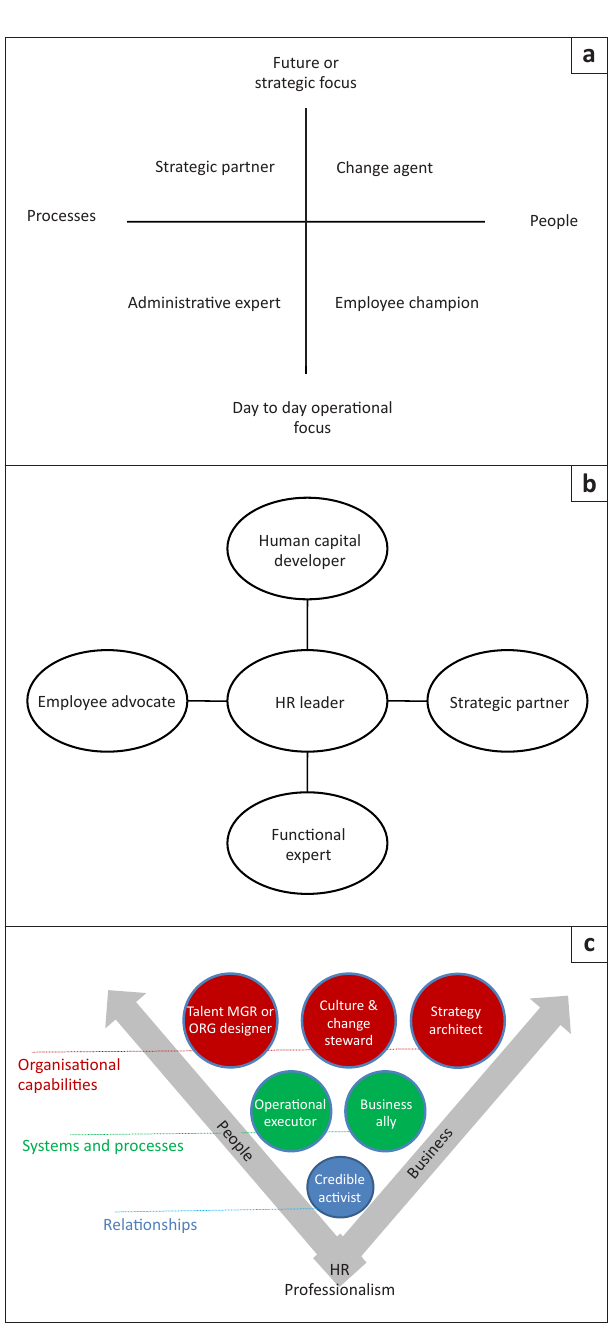
FIGURE 1: Evolution of multiple role models of HRM (a) phase 1 of the HRM role model, (b) phase 2 of the HRM role model, (c) phase 3 of the HRM role